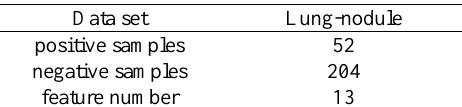
Table 1. Experiment data sets